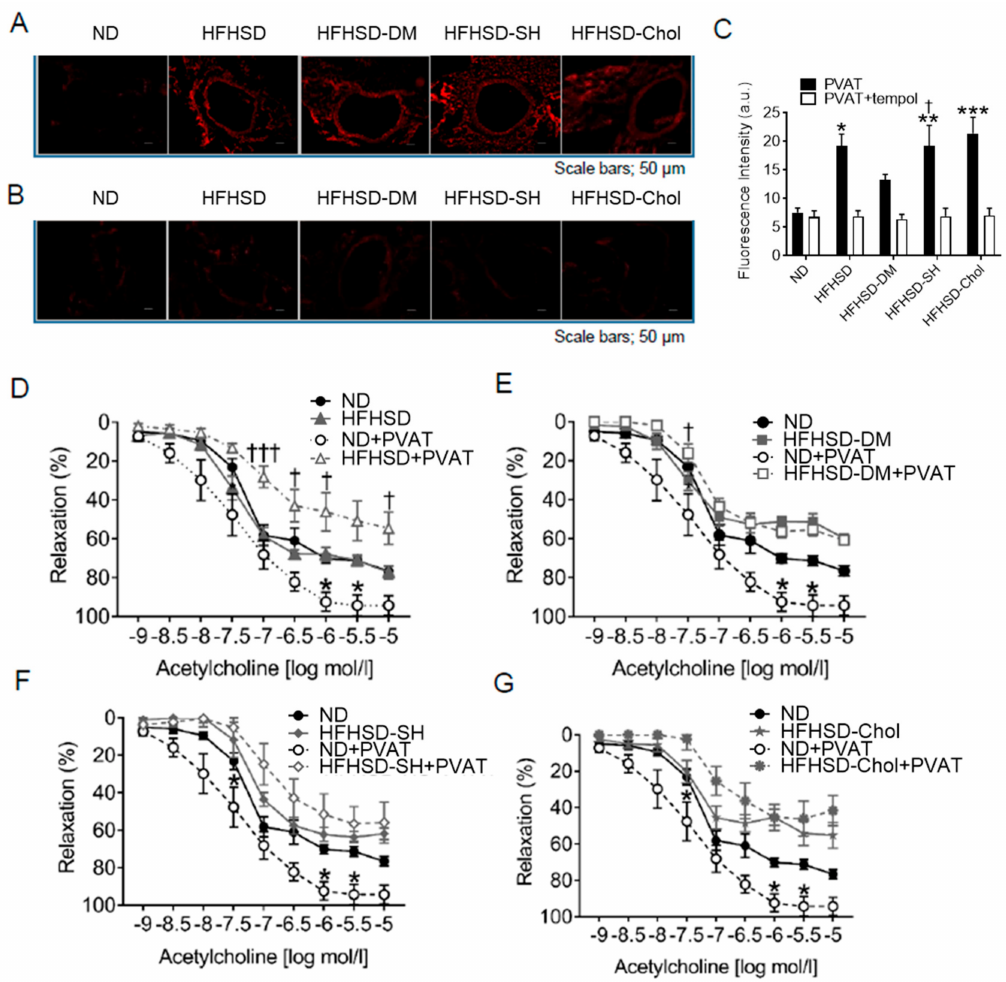
Figure 4. PVAT increased EDR in the ND group but decreased EDR in the HFHSD group and was accompanied by increased superoxide production from PVAT: ( A ) DHE staining of aortic rings with PVAT and ( B ) with tempol; ( C ) quantification of DHE fluorescence (n = 8 for each group). Vascular relaxation of aortic rings with PVAT or without PVAT on acetylcholine in the HFHSD group ( D ), HFHSD-DM group ( E ), HFHSD-SH group ( F ), and HFHSD-Chol group ( G ) (n = 8 for each